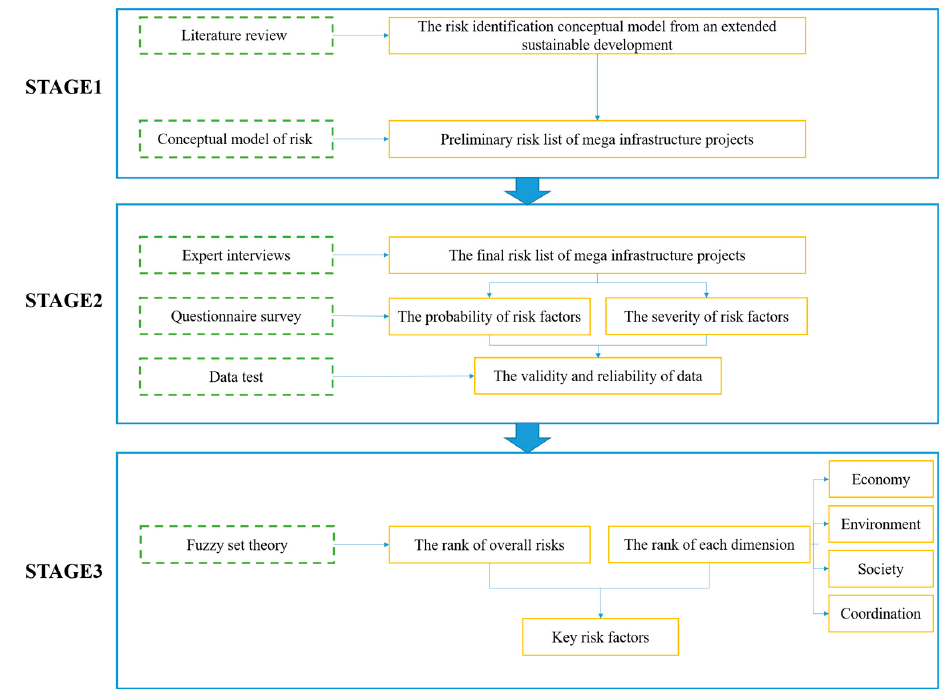
Figure 1. The research